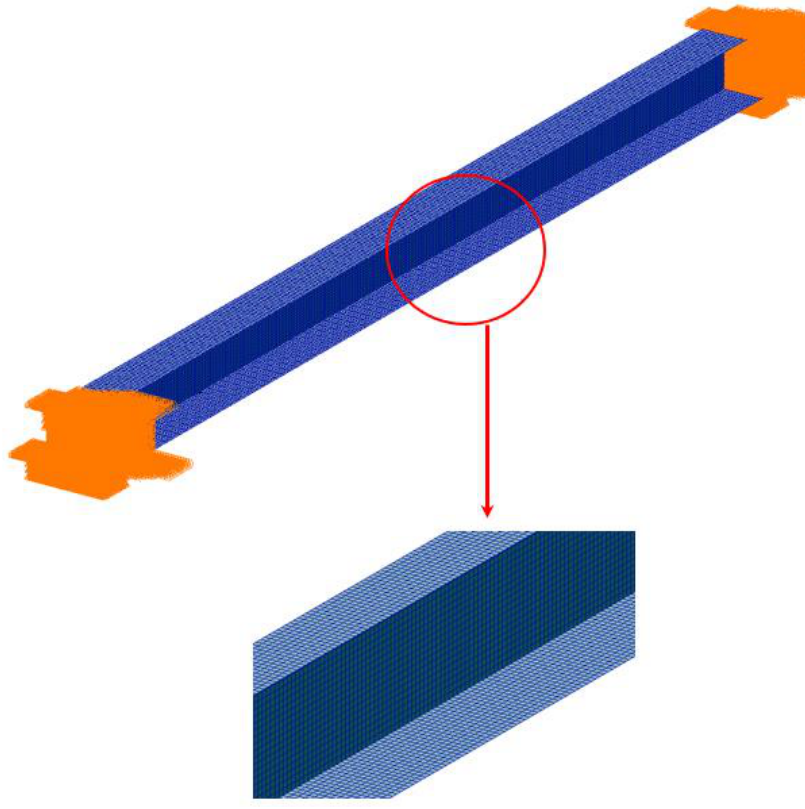
Figure 2. Mesh and boundary